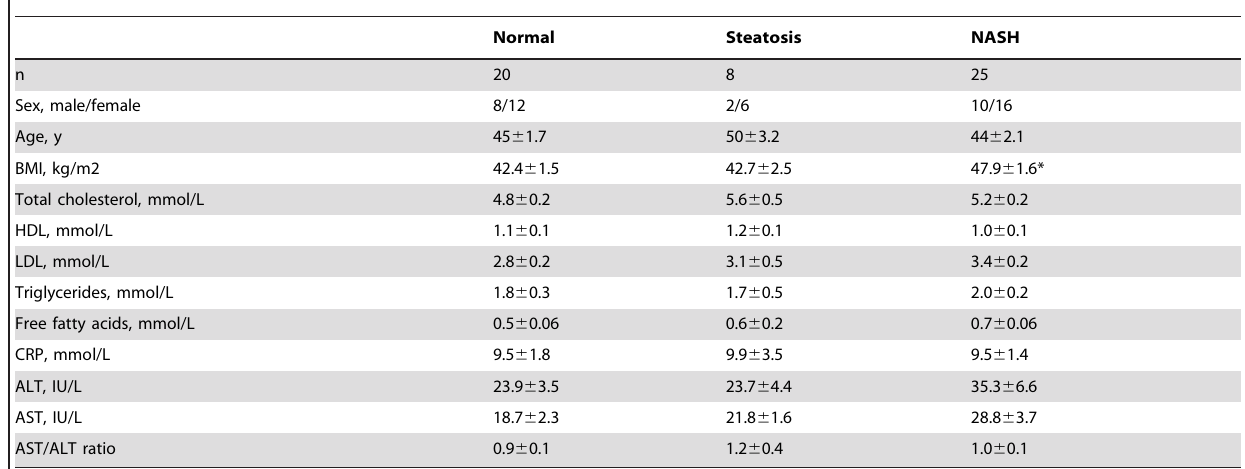
Table 1. Population characteristics.